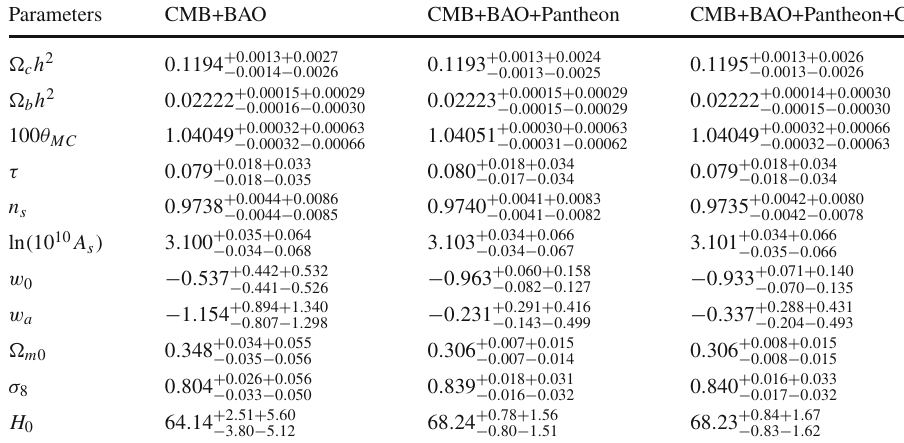
constraints on various free parameters at 68% and 95% CL for the dynamical dark energy state parameter w x ( z ) = (Gen) using different astronomical datasets have been presented. Let us note that (cid:12) m 0 is the present value of